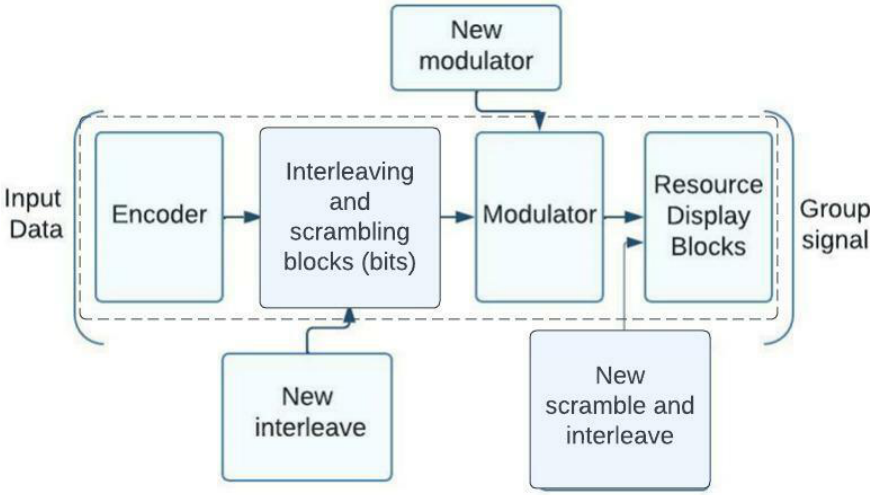
Figure 1. NOMA system transmitting side structure based on 5G standard.